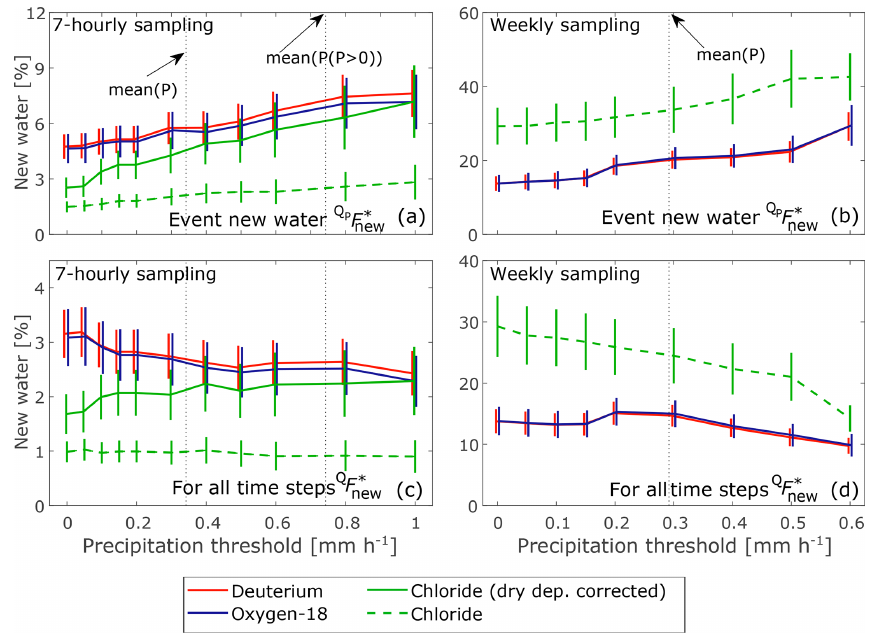
Figure 8. Effects of different precipitation thresholds on volume-weighted new water fractions for 7-hourly sampling at Upper Hafren (a, c) and weekly sampling at Lower Hafren (b, d) . Error bars indicate 1 standard error. Panels (a) – (b) show volume-weighted event new (cid:16) Q (cid:17) water fractions , which consider only time steps with precipitation. Higher precipitation thresholds lead to higher new water p F ∗ new fractions in these panels, because time steps with low precipitation rates are usually associated with lower discharges. As these are excluded, fewer and fewer low-flow time steps are considered, increasing the relative importance of time steps with high discharge, which also tend to have higher new water fractions. Conversely, the precipitation threshold has less effect on volume-weighted new water fractions for all time steps ( Q F ∗ new , c–d ), because these include a factor that accounts for the fraction of days without precipitation. Precipitation thresholds have been slightly jittered for better visibility of the different